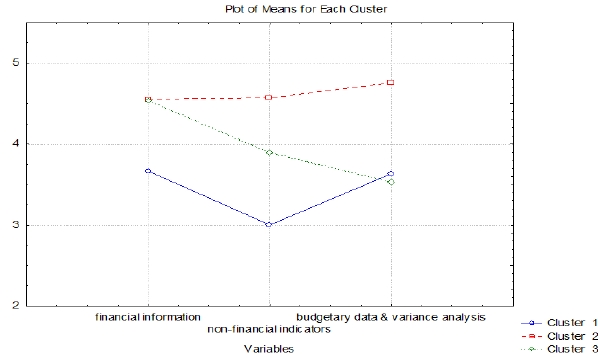
Fig. 8. Object (respondent) grouping with the k-means method in respect of the assessed suitability of selected management accounting information in Romania